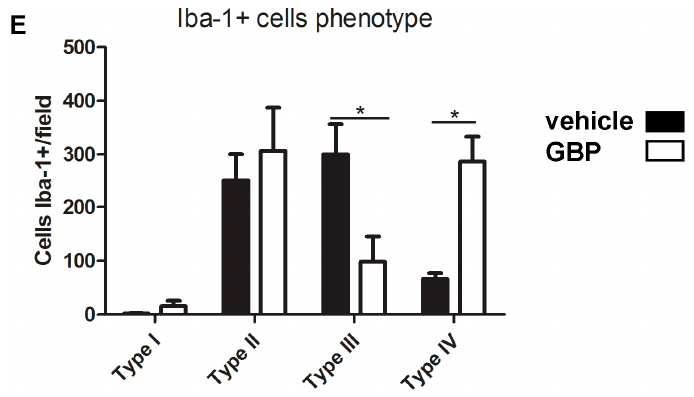
Figure 5. Gabapentin treatment reduces reactive microgliosis in SE animals. ( A ) Representative images of Iba-1+ immunostained microglial cells in the piriform cortex of gabapentin- (GBP) and vehicle-treated animals at 5DPSE. Scale bar: 15 µ m. ( B , C ) Quantitative analysis of area fraction occupied by Iba-1+ microglial cells in GBP- and vehicle-treated animals after 5DPSE in the piriform cortex and hippocampal stratum radiatum CA-1 respectively. Significance was evaluated by Student- t -test (* p < 0.05), data are expressed as mean ± SEM. ( D ) Representative images of microglial phenotypes used for characterizing the reactive microgliosis in type I, II, III and IV. ( E ) Quantitative analysis of the Iba-1+ microglial phenotypes in the piriform cortex after 5DPSE in vehicle- (white bars) and GBP-treated (black bars) animals. Data are expressed as mean ± SEM; (* p < 0.05) after one-way ANOVA and Bonferroni post-test.